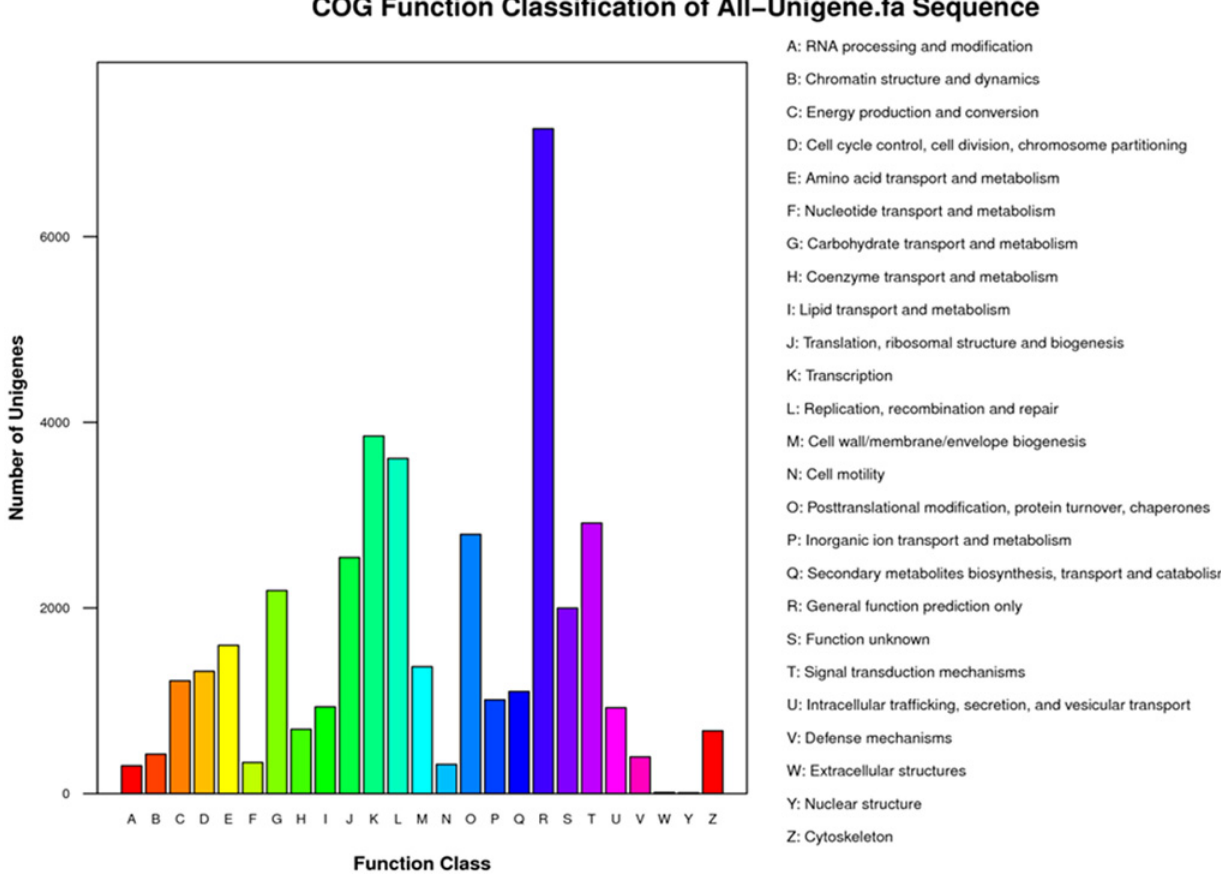
Fig 4. COG function classification. All the unigenes aligned in COG database were assorted in 25